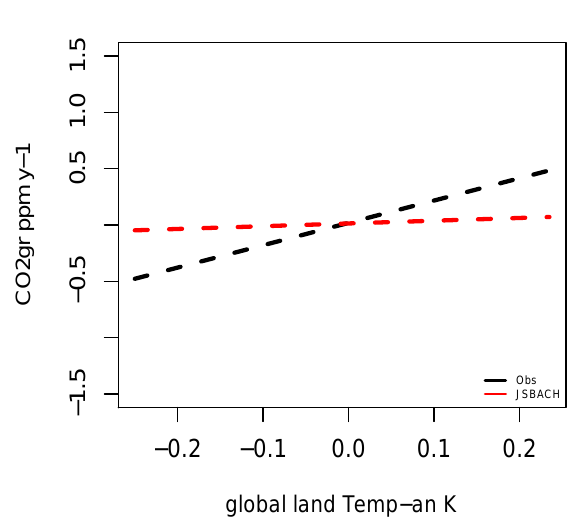
Fig. 10. Apparent land-C sensitivity: CO 2 growth rate in Mauna Loa (MLO) versus global land surface temperature. Regression is signif- icant at P < 0 . 01 for observations. Annual data points are omitted for